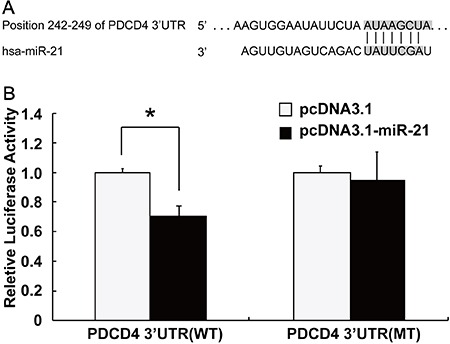
MicroRNA-21 (miR-21) directly targeting programmed cell death 4 (PDCD4).
A: combined sequences of PDCD4 mRNA and microRNA-21 in
3′-UTR binding site; B, Dual-luciferase reporter analysis
results: the activity of luciferase showed no significant difference in the
group transfected with carriers of miR-21 and mutant (MT) PDCD4 mRNA
(P>0.05), while the activity of luciferase was significantly decreased in
the group transfected with carriers of miR-21 and wild type (WT) PDCD4 mRNA
expressions (P<0.01); *P<0.05, pcDNA3.1-miR-21 group
(transfected) compared to pcDNA3.1 group (negative control) (Student
t-test).